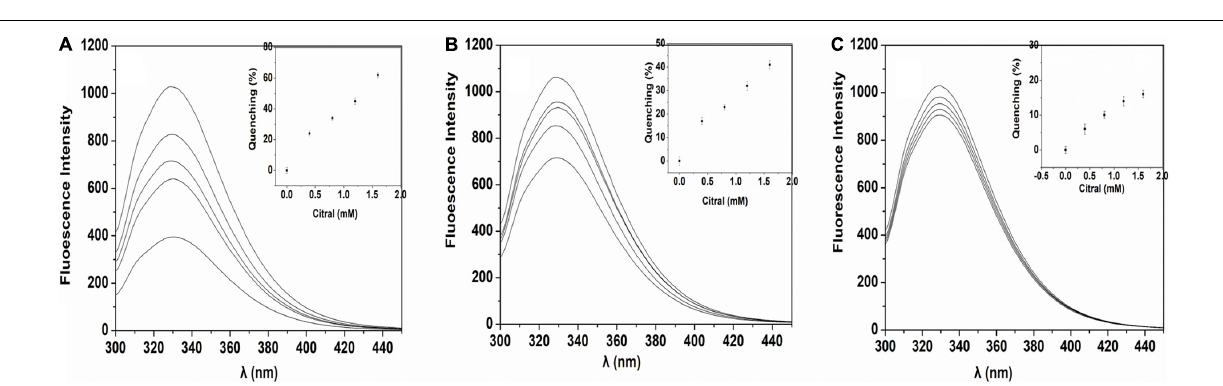
TABLE 1 | Surface hydrophobicity and protein solubility of N-SPI, H-SPI, L-SPI.